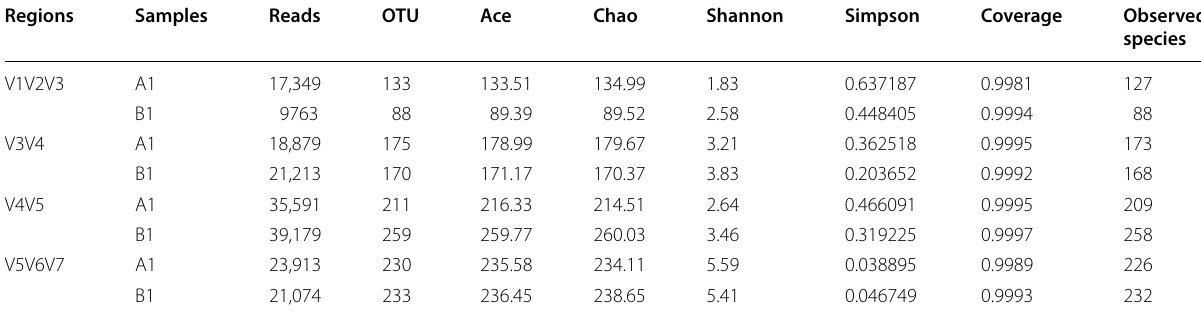
Table 2 Numbers of sequences analyzed for the two samples Regions